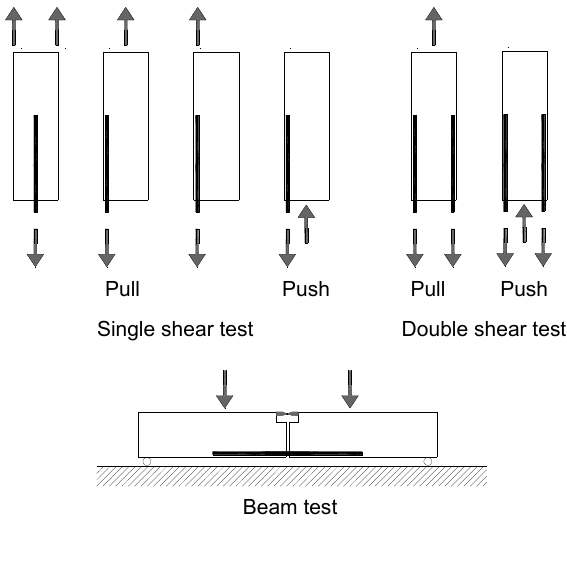
Figure 1. Different test